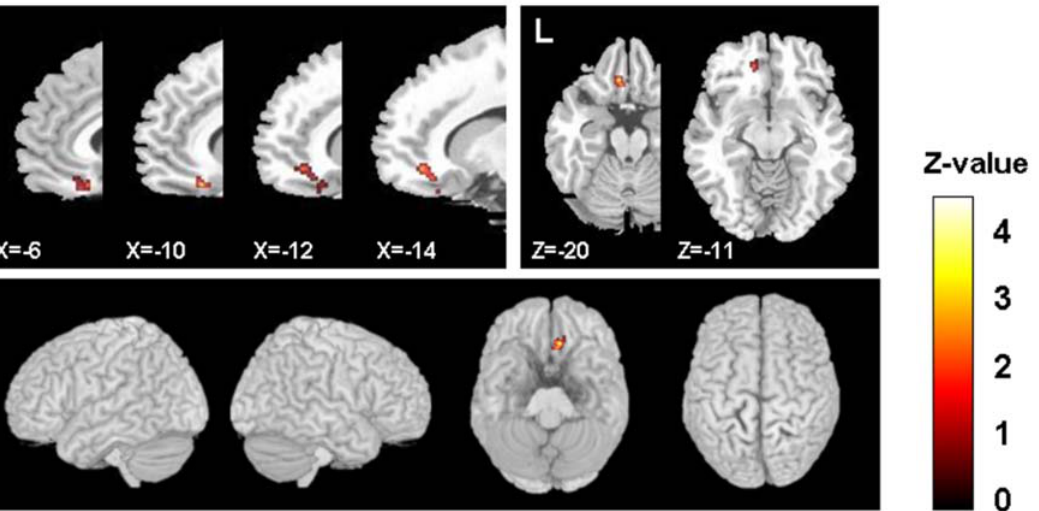
Figure 1. Sagittal and transverse sections of the statistical parametric map of the changes in [ 11 C]FLB 457 BP after left DLPFC stimulation overlaid upon the standard MRI. doi:10.1371/journal.pone.0006725.g001 PLoS ONE |